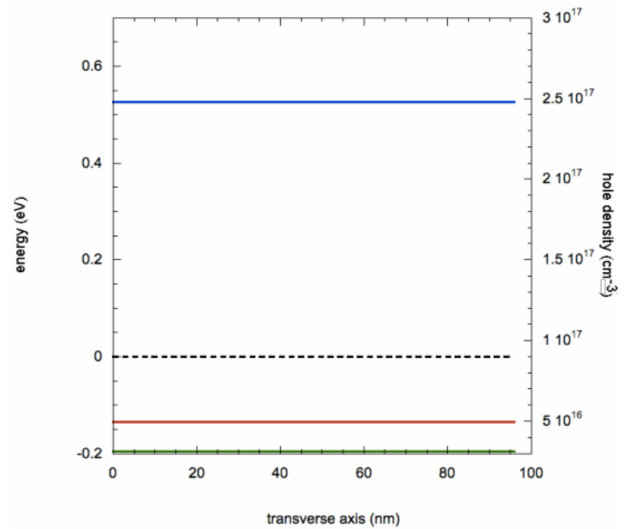
Figure 4. Values for energy bands (blue: bottom of conduction band, red: peak of valence band), Fermi level (dashed black line) and carrier density (green line) along the transverse axis for a Ge NW without surface